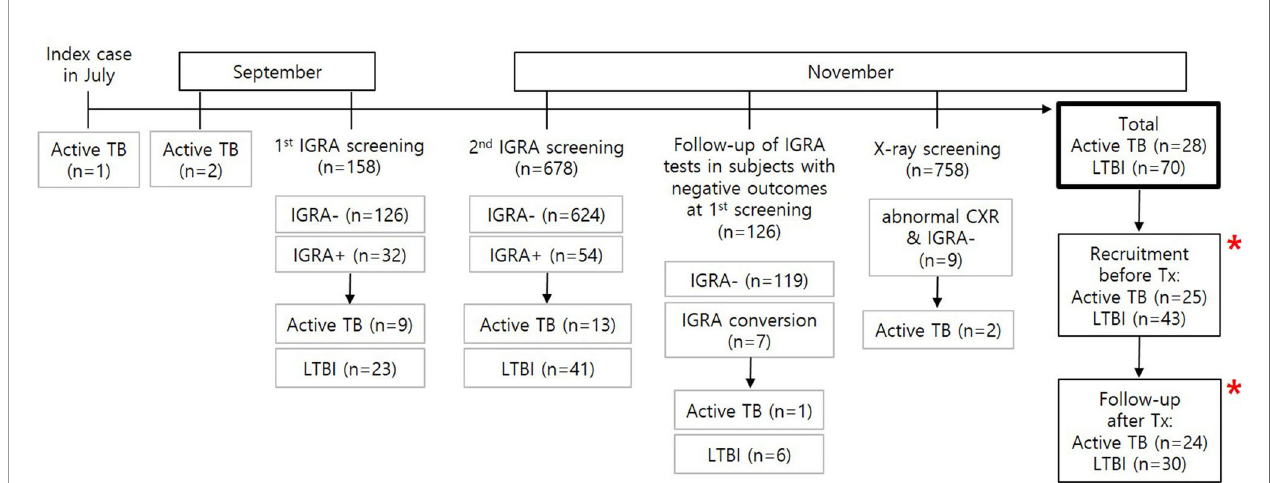
FIGURE 1 | Flowchart of M. tb infection screening during the TB outbreak and recruitment of study subjects. A total of 28 active patients with TB and 70 individuals with LTBI were found based on contact screening tests for M. tb infection in 758 individuals. Among the contacts, 25 TB patients and 43 subjects with LTBI were recruited for this study. Immune responses were followed up in 24 patients with TB and 30 subjects with LTBI after successful treatment. * MTBK antigen tubes were